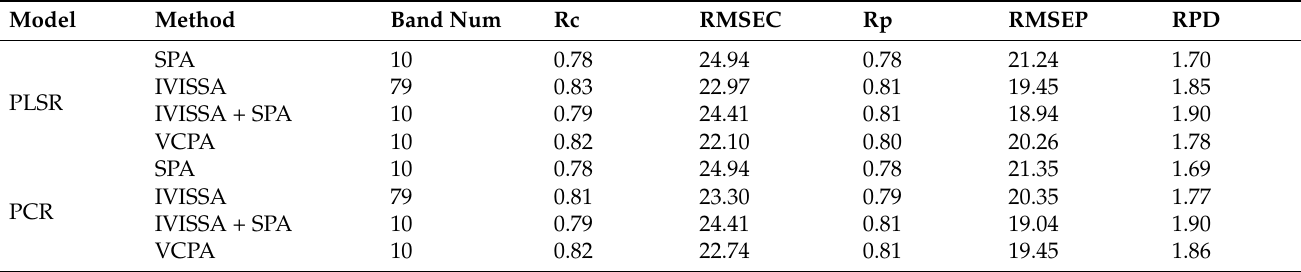
Table 4. Comparison of modeling effects of different feature extraction